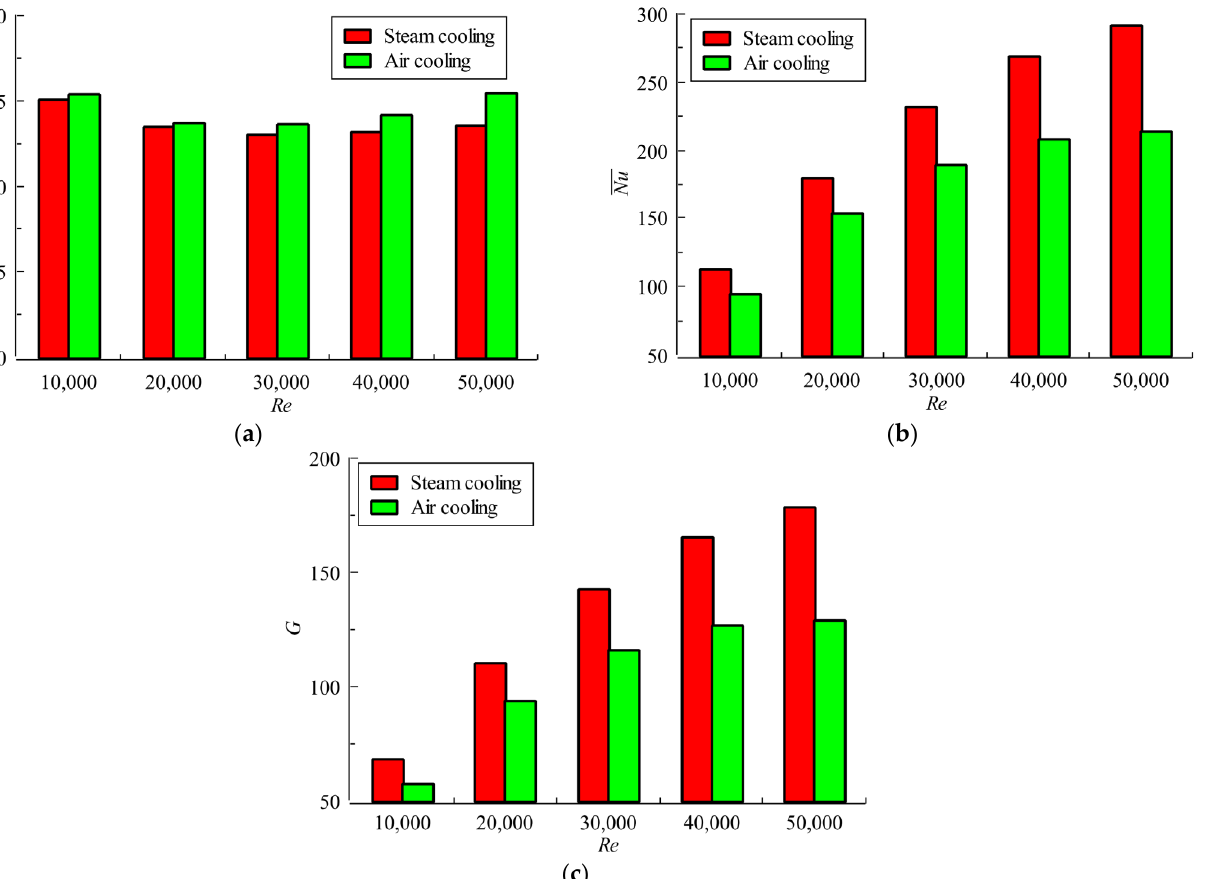
Figure 14. Comparisons of the pressure loss coefficient, average Nusselt number, and comprehensive thermal coefficient of the quasi-leading-edge channel for steam cooling and air cooling: ( a ) pressure loss coefficient; ( b ) average Nusselt number; ( c ) comprehensive thermal coefficient.